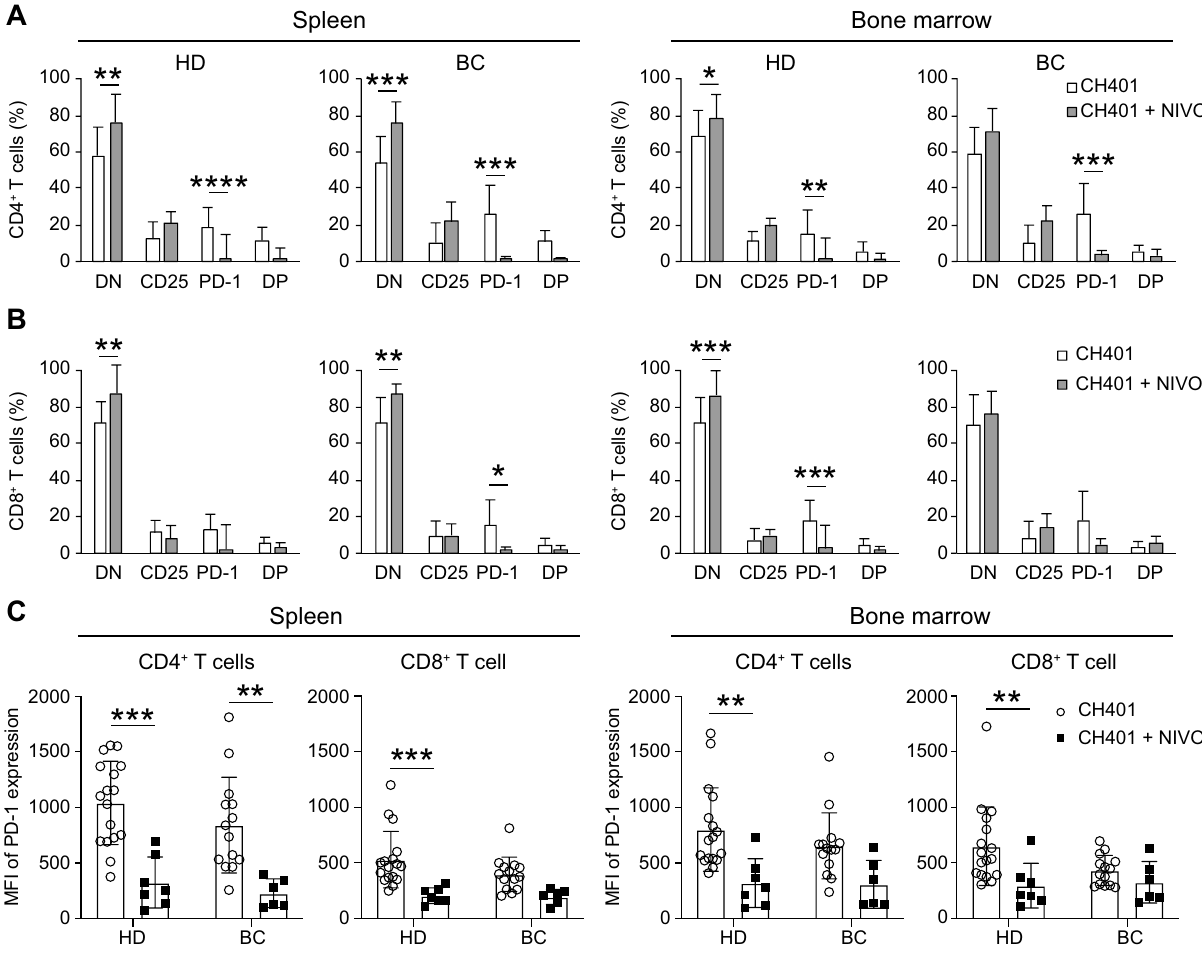
Figure 6. Effects of nivolumab on the activation/exhaustion of engrafted human T cells. Effects of NIVO on human T cells localized in the spleen and bone marrow of mice transplanted with HD (CH401MAP; n = 17, CH401MAP + NIVO; n = 7) or BC (CH401MAP; n = 13, CH401MAP + NIVO; n = 6) PBMCs. CD25 and PD-1 expression in (A) CD4 + T cells and (B) CD8 + T cells localized in the spleen and bone marrow of mice transplanted with HD or BC PBMCs. Double-negative DN; CD25 − PD-1 − , CD25; CD25 + PD-1 − , PD-1; CD25 − PD-1 + , Double-positive DP; CD25 + PD-1 + . CH401MAP and CH401MAP + NIVO administration shown as white (CH401MAP) or gray (CH401MAP + Nivolumab) bars. * p = 0.05, ** p = 0.01, *** p = 0.001, **** p = 0.0001. (C) MFI of PD-1 expression on CD4 + T cells or CD8 + T cells in the spleen and bone marrow of hu-PBL hIL-4 NOG mouse. * p = 0.05, ** p = 0.01, *** p = 0.001, **** p = 0.0001. BC breast cancer; HD healthy donor; PBMCs peripheral blood mononuclear cells; MFI mean fluorescence